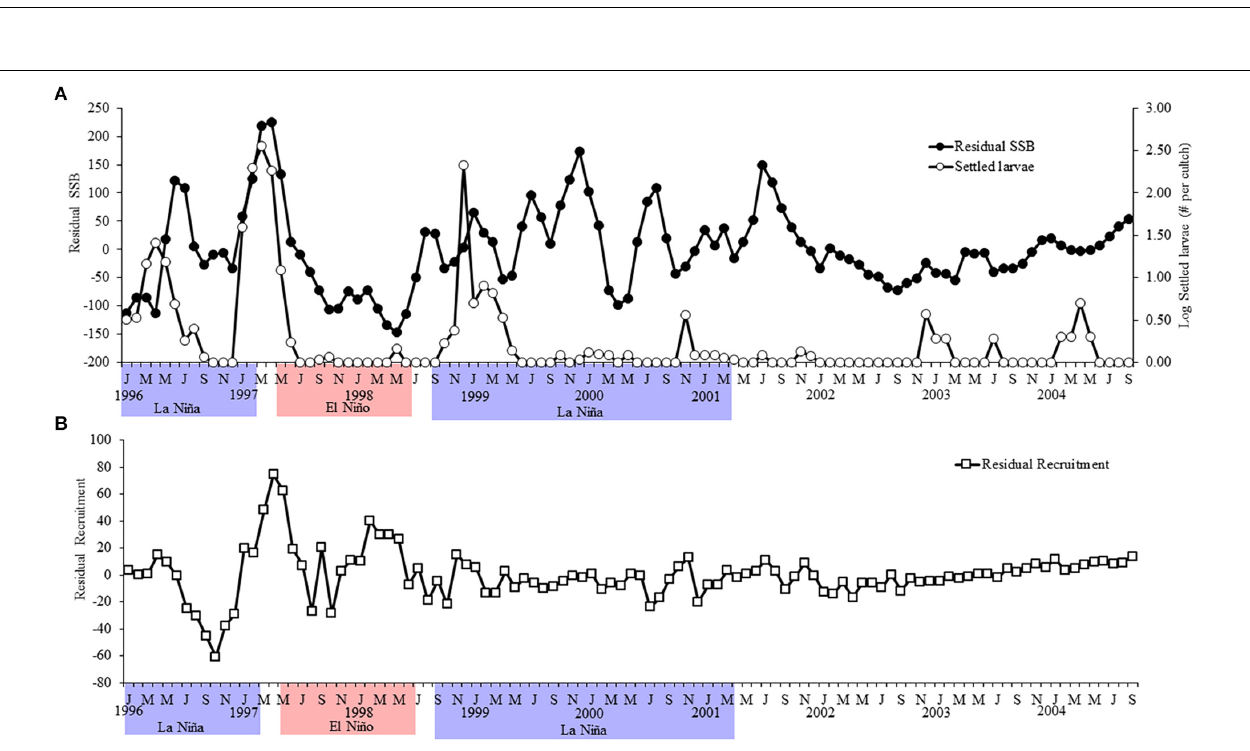
FIGURE 3 | Residual variability of (A) the spawning stock biomass and the larval settlement and (B) the recruitment of A. atra . Red and blue background denote the timing of EN and LN episodes, respectively, according to the El Niño-Coastal Index.